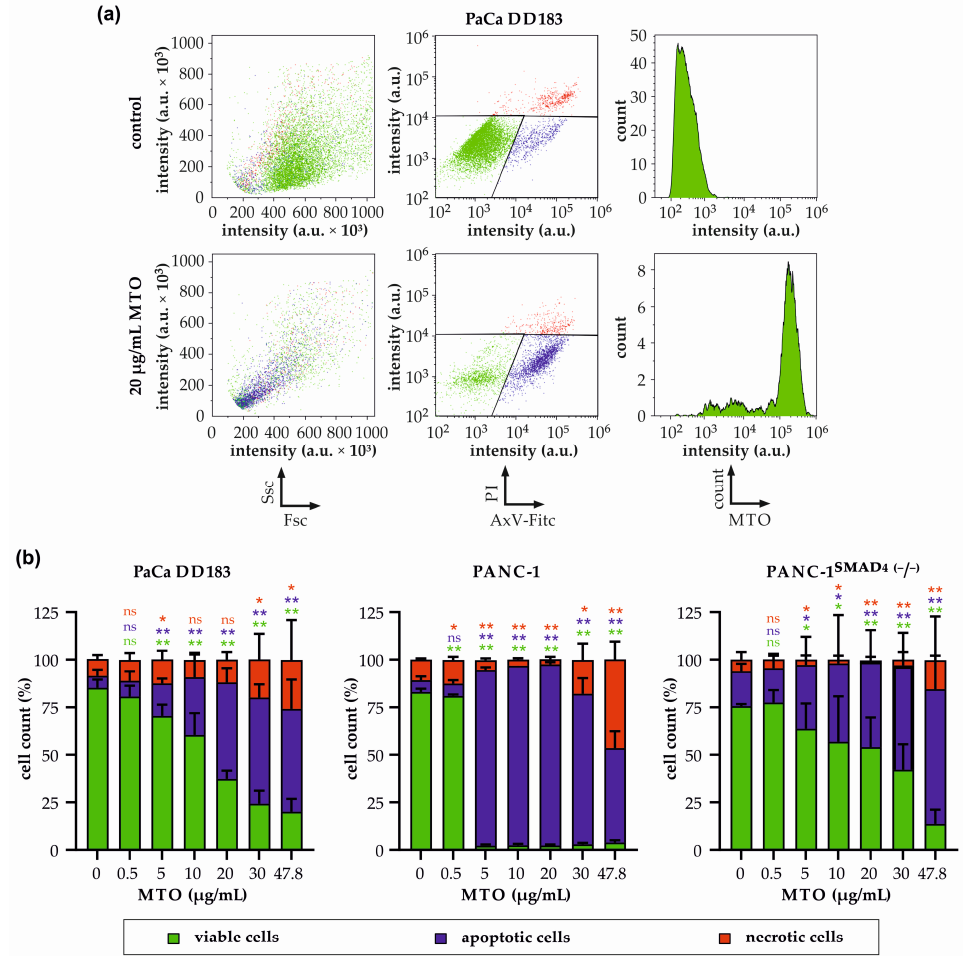
Figure 3. Influence of free MTO on PDAC tumor cell spheroids measured by flow cytometry. ( a ) Gating strategy. Shown are the representative plots and histograms of cells from PaCa DD183 spheroids after 4 days of treatment with 20 µg/mL MTO (second row) or with the corresponding amount of H 2 O (first row). Left panels exemplarily show cell morphology (forward scatter, Fsc, versus side scatter, Ssc), middle panels depict AnnexinV (AxV)-Fitc and propidium iodie (PI) staining, and right histograms represent mitoxantrone (MTO) uptake. ( b ) Cell viability of PaCa DD183, PANC-1, and PANC-1 SMAD4 ( − / − ) spheroids was determined by Annexin V-FITC/propidium iodide (AxV/PI) staining and analyzed by flow cytometry. Ax − /PI, Ax+/PI and PI+ cells were considered viable, apoptotic and necrotic, respectively. MTO concentrations were used as indicated. Statistical significances are indicated with * and **. The respective confidential intervals are * p ≤ 0.05